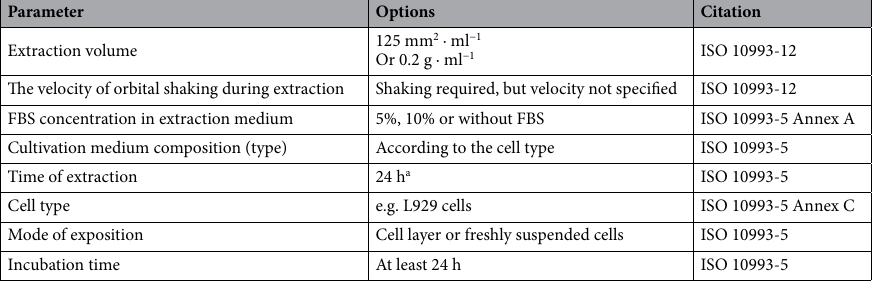
Table 1. Parameters and options of elution test stated in ISO 10993. a When cultivation medium with serum is